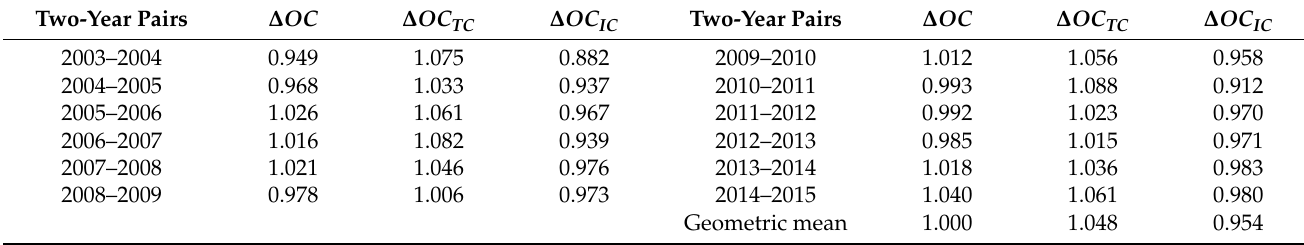
Table A2. ∆ OC , ∆ OC TC and ∆ OC IC for two-year pairs (30